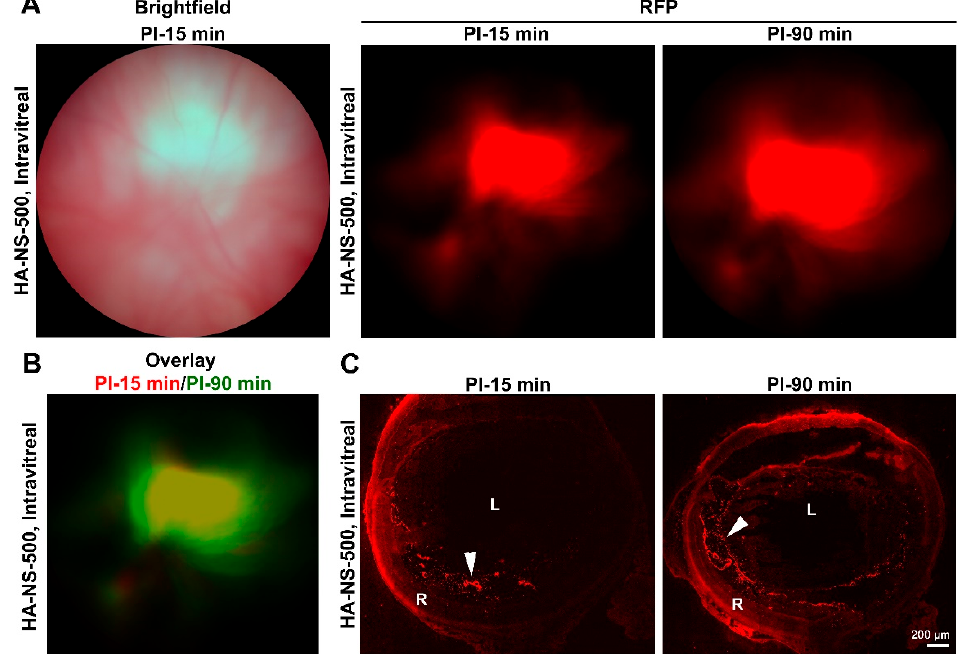
Figure 3. Short-term distribution of HA-NS-500 after intravitreal injection. Adult Balb/C mice were intravitreally injected with HA-NS-500 (2 µL at 5.0 × 10 6 HA-NS-500/µL). ( A ) Left: Shown is a brightfield fundus image captured at PI-15 min. Right: Shown are fundus images captured using RFP filters at 15 and 90 min post-injection. ( B ) To observe how distribution of the HA-NS-500 signal changes over time, the PI-15 min image is shown in red with the PI-90 min image overlaid in pseudocolored green. ( C ) Injected eyes were harvested at the indicated timepoints and serially cryosectioned. Shown are representative sections with HA-NS-500 fluorescence shown in red. Arrowheads highlight accumulation of HA-NS-500 between the lens and retina, and along the inner limiting membrane. L: lens, R: retina Scale bar: 200 µm.